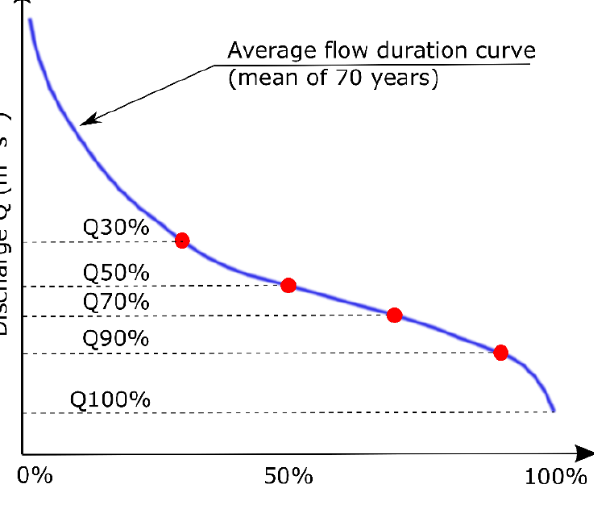
Figure 2. Flow duration curve.